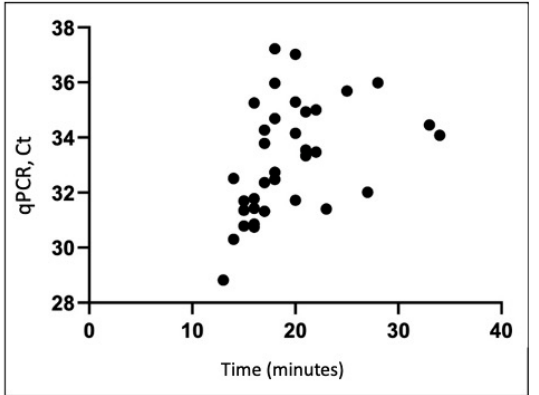
Figure 3. Comparison of qRT-PCR Ct values and LAMP detection of SARS-CoV-2 RNA in collected environmental samples ( R 2 = 0.19). LAMP, loop-mediated isothermal amplification; qRT-PCR, quantitative real-time polymerase chain reaction; SARS-CoV-2, severe acute respiratory syndrome coronavirus 2.